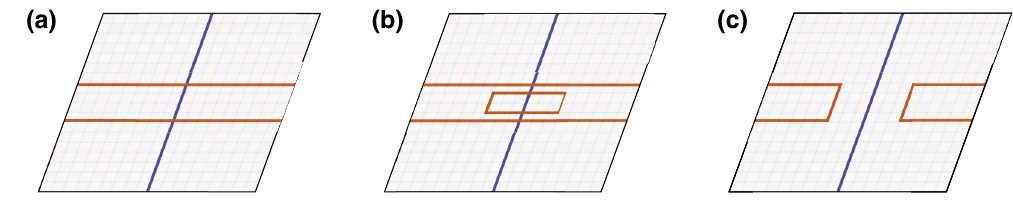
FIG. 29. Commuting traceable operators can be resolved to only have intersections on strings of the same type. For simplicity, we consider a setting absent of domain walls—the general case holds using the same argument up to local string relabelings. Label the two traceable operators P and Q . (a) In a region, P is depicted on the left by a single primal (blue) string, while Q is a pair of dual (red) strings. For P and Q to commute, the primal strings of P must overlap an even number of times with the dual strings of Q . (b) Consider pairing up the primal and dual intersections between P and Q . For each intersection, we can multiply by a trivial dual loop (i.e., a stabilizer) in the neighborhood of the intersection. (c) This loop resolves the crossings, and so we are left only with intersections of the same